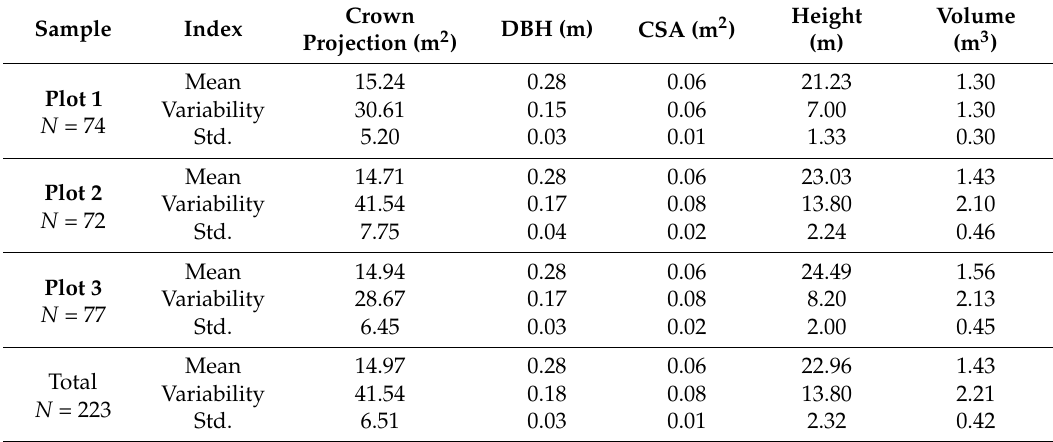
Table 2. Descriptive statistics of the three plots based on ground